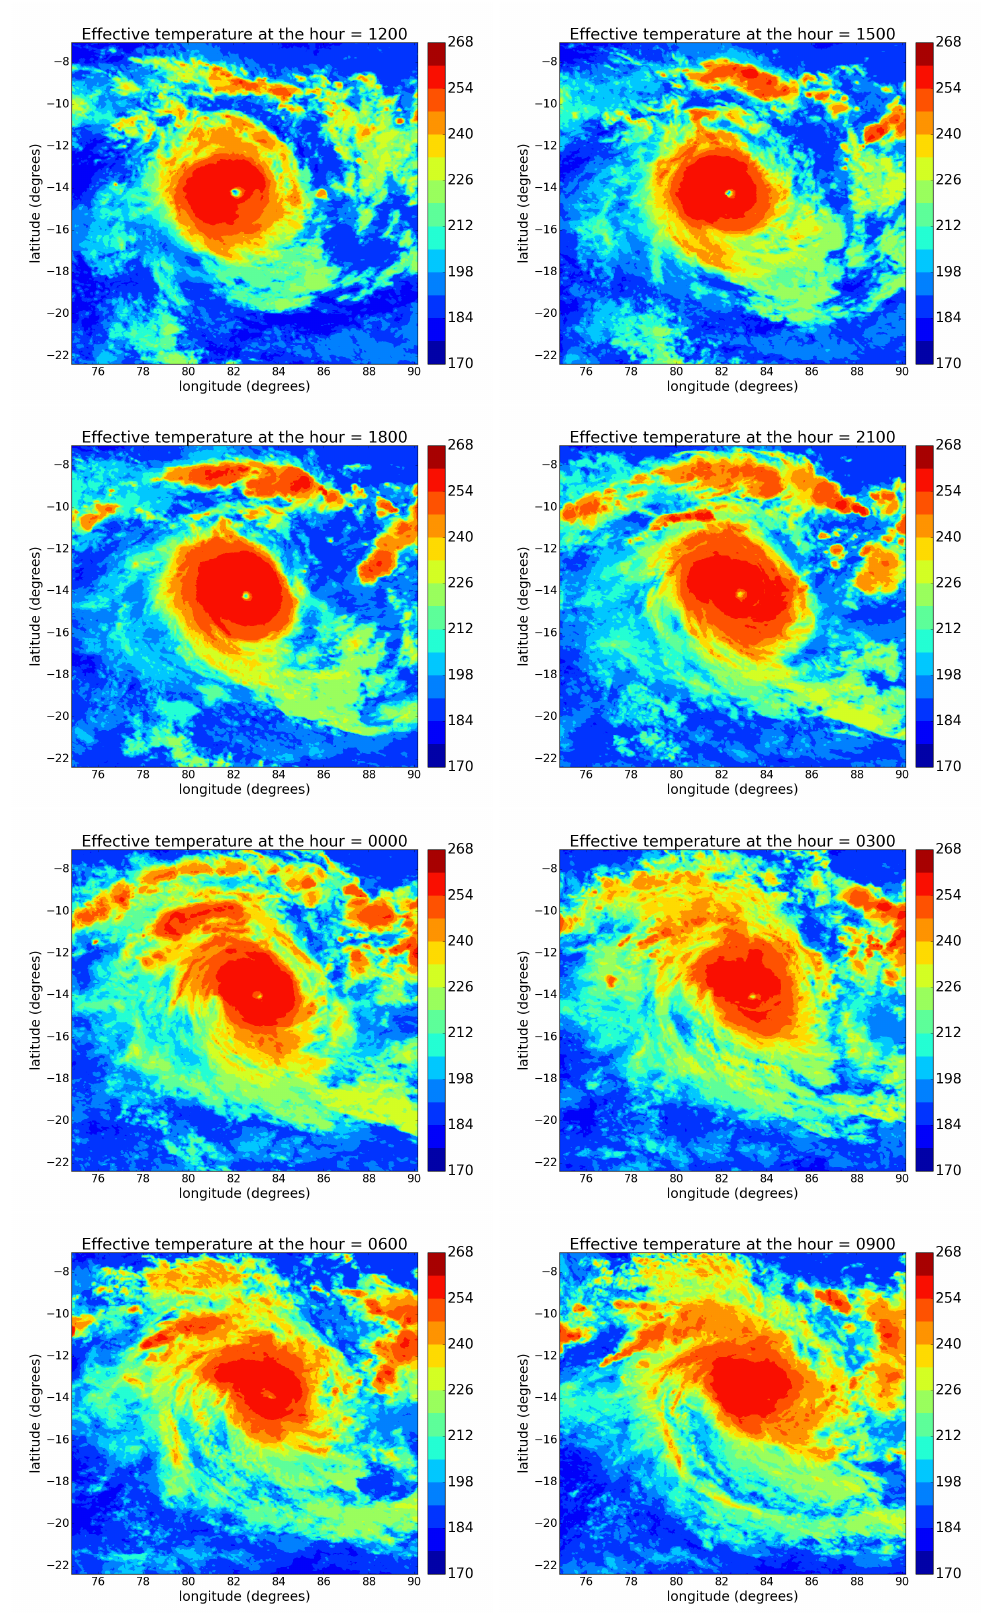
Figure 4. Shaded images of effective temperature evolution in time of Faraji cyclone, from 12.00